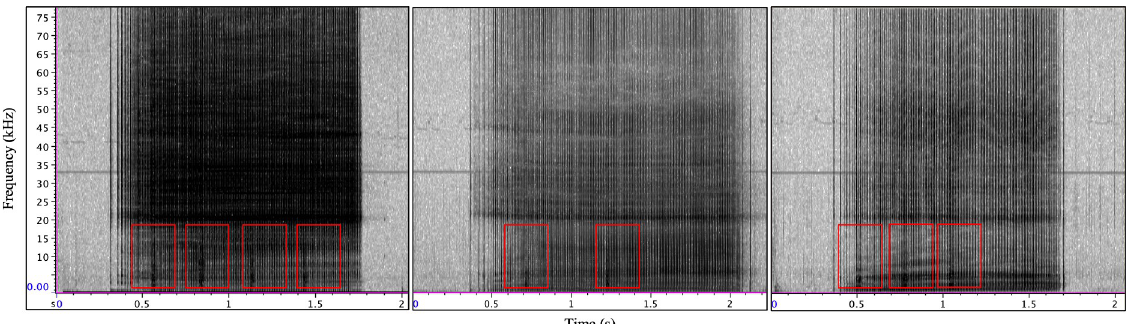
Fig 1. Type E examples from sample used for parameter extraction (n = 33). The far left panel is a type E call recorded during Eistla’s tagging event when the Acousonde was held underwater near her head. The center and right panels are type E examples from the remainder of the recording period following Eistla’s release. Red boxes indicate type E overlapping pulsed components. Spectrogram parameters: DFT size 512, 256 sample hop size, and Hann window 512 samples.